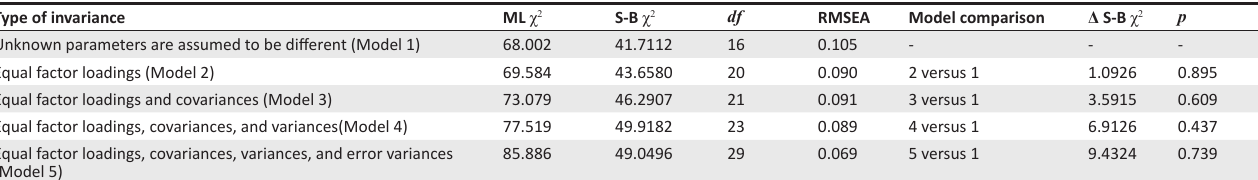
TABLE 5: Multi-group confirmatory factor analysis Results (Race). Type of